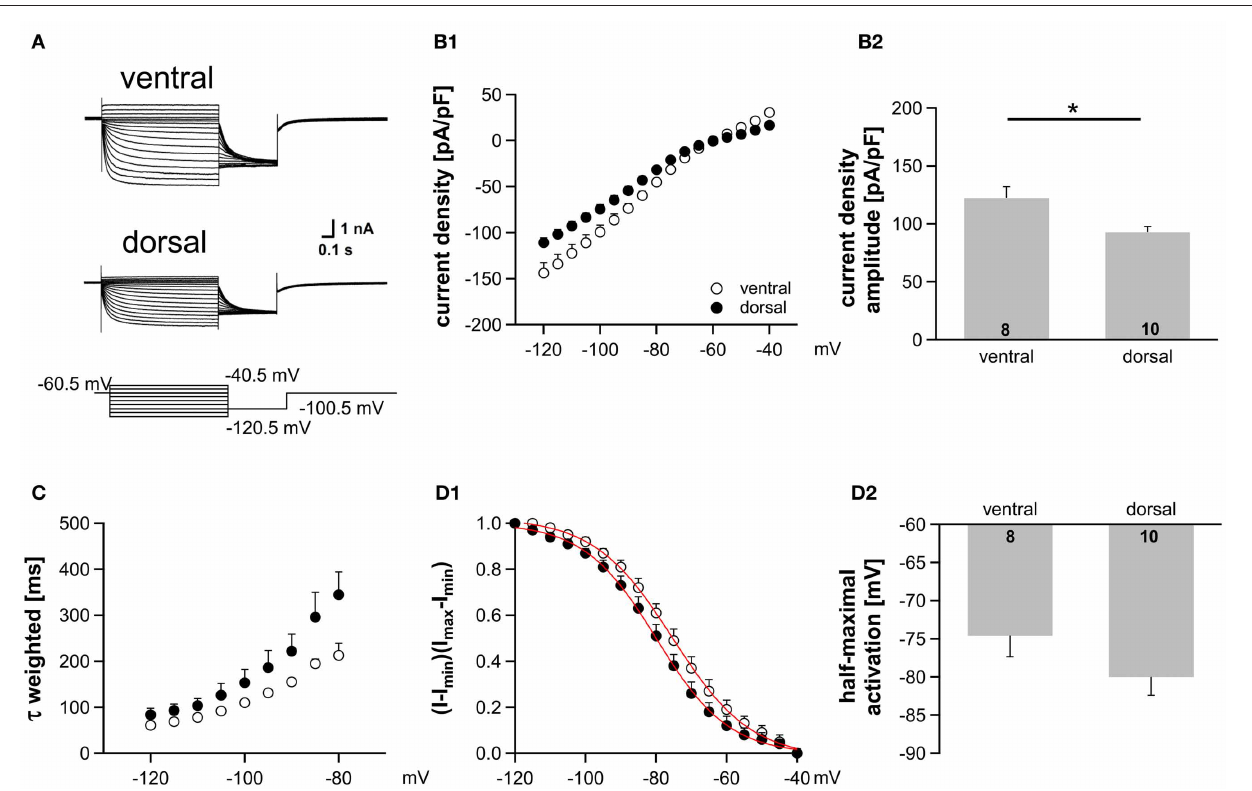
FIGURE 5 | I h gradient persists in more mature animals (P22). (A) Pharmacologically isolated I h current traces were elicited by depolarizing and hyperpolarizing voltage steps from − 60.5mV to potentials between − 40.5mV and − 120.5mV (5mV step increment). Current traces are representative for the dorsal and the ventral part of the MSO. (B) I-V relationships of steady-state I h density for ventral ( n = 8) and dorsal ( n = 10) neurons emphasize that I h density amplitudes are smallest in dorsal neurons and largest in ventral